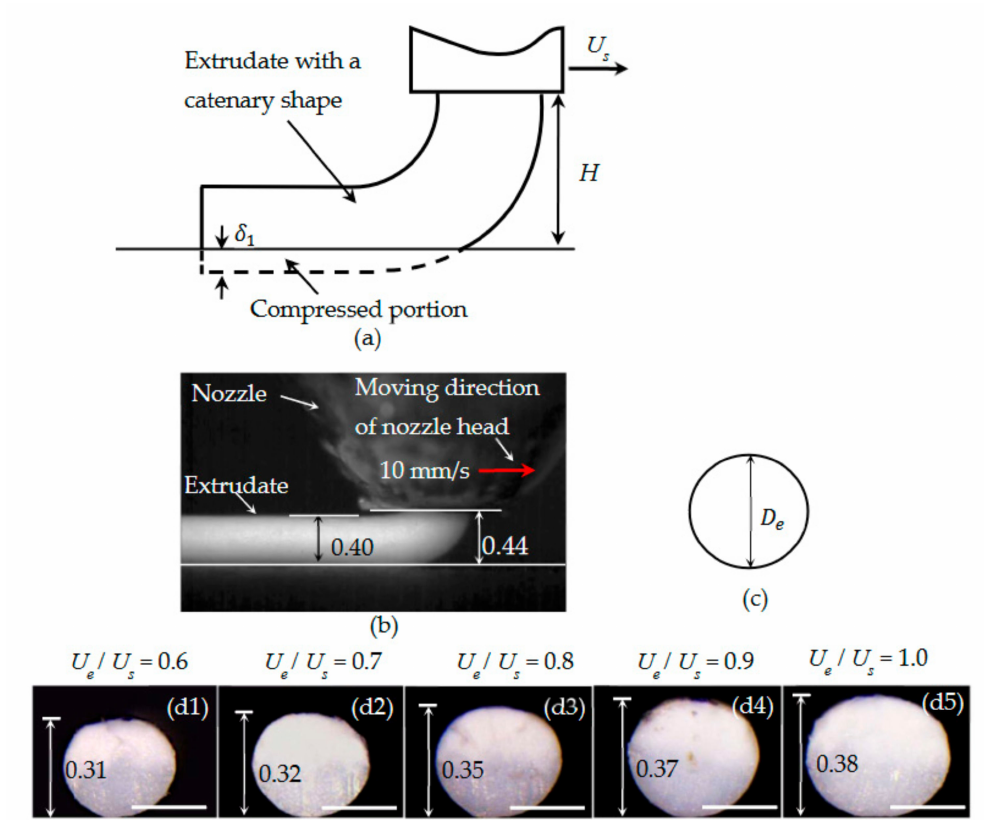
Figure 3. ( a ) Illustration of Case I.1. ( b ) A representative example, in which an acrylonitrile butadiene styrene (ABS) filament was extruded through a nozzle with diameter 0.40 mm, when H = 0.44 mm and U e = U s = 10 mm/s. ( c ) Predicted circular cross-section of a deposited strand. ( d1 – d5 ) Cross-sections of the deposited strands, with H fixed to be 0.5 mm and U e /U s ranging from 0.6 to 1.0. Scale bar: 0.25 mm. The units in ( d1 – d5 ) are all mm, which also applies to all of the following